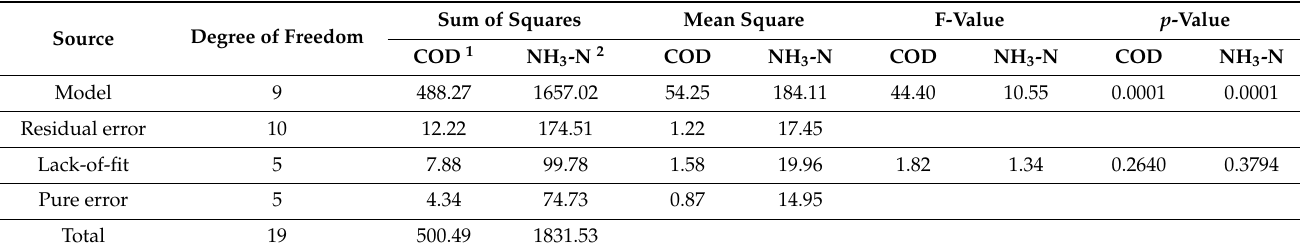
Table 5. Analysis of the variance (ANOVA) for removing COD and NH3-N from SPRE using FeSO 4 · 7H 2 O waste as a